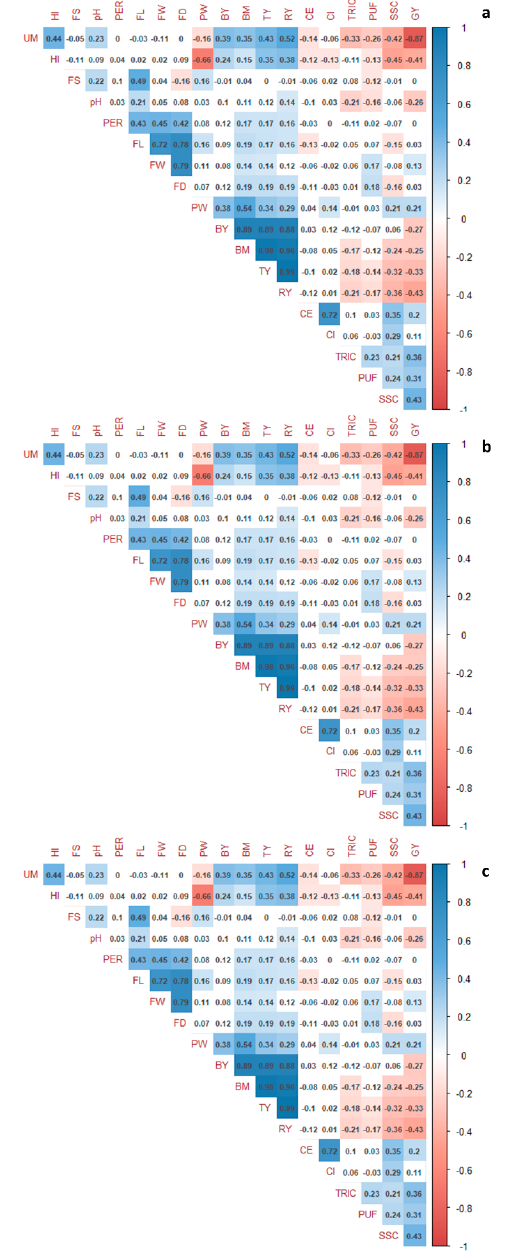
Figure 3. Pearson’s rank correlation coefficients between the pairs of phenotypes. The correlation coefficients are indicated in each cell. Colored correlations are those with p -values < 0.01 after Bonferroni correction. The color intensity is directly proportional to the coefficients. On the right side of the correlogram, the color legend shows the correlation coefficients and the corresponding colors. ( a ) The correlogram for the traits scored in year 1, ( b ) year 2, and ( c ) year 3. The trait acronyms are in Table